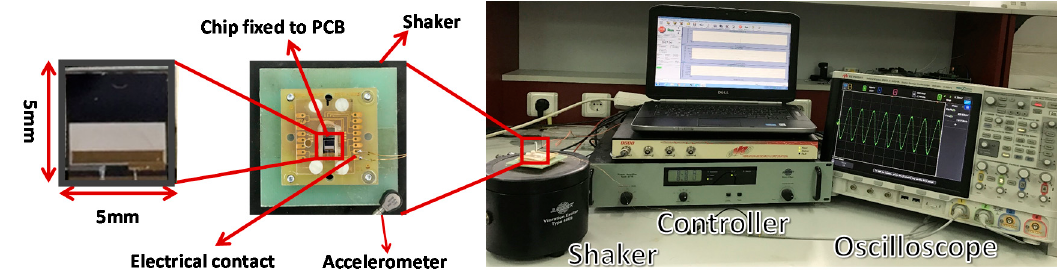
Figure 5. The test setup and the fabricated MEMS device with a close-up view of the transducer.